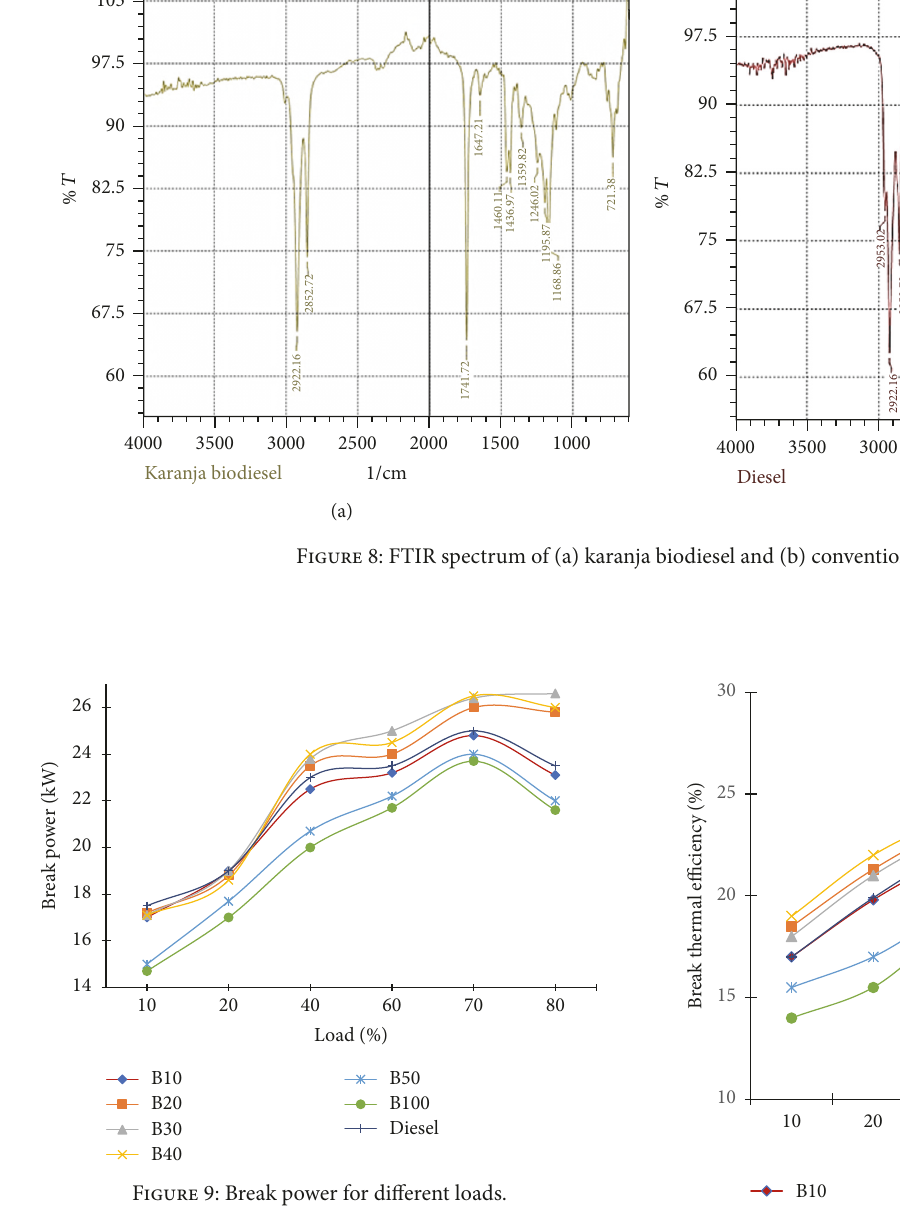
Figure 9: Break power for different loads.